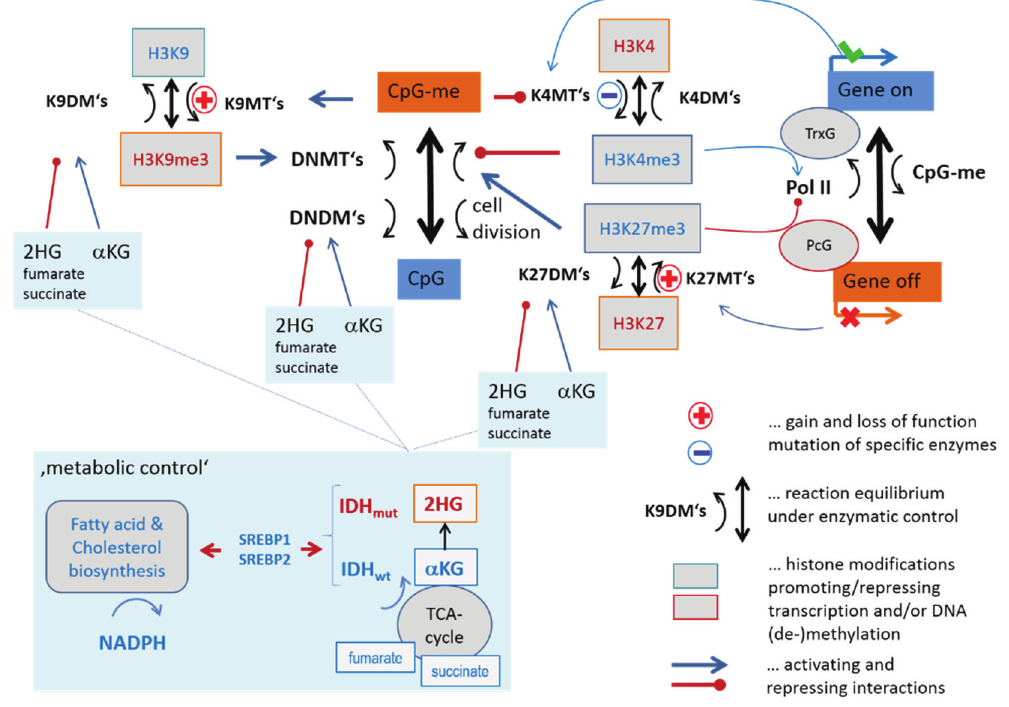
Figure 3. Transcription and DNA (promoter-) methylation under enzymatic control: The scheme summarizes selected regulatory paths affecting histone, CpG-methylation and gene expression via different histone and DNA methylating and demethylating